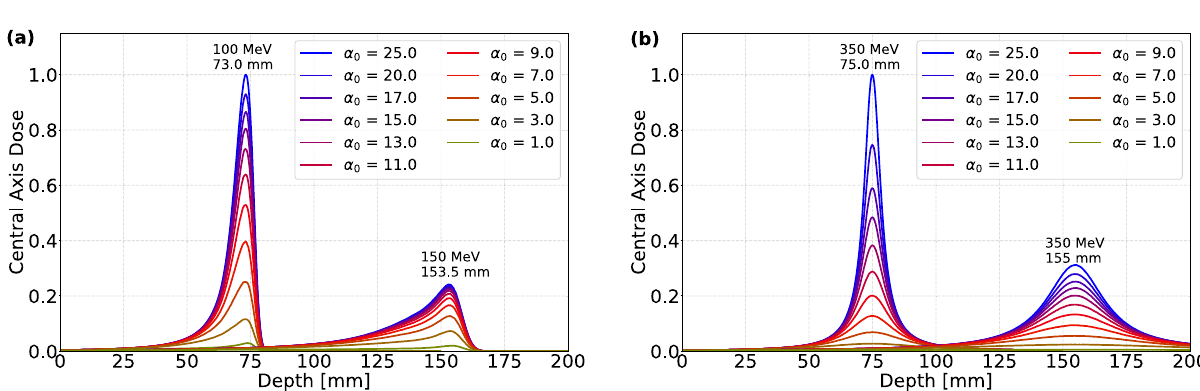
Figure 6. Evolution of central axis dose calculated with a narrow cylinder for ( a ) CEFP beam and ( b ) HEFP beam as a function of